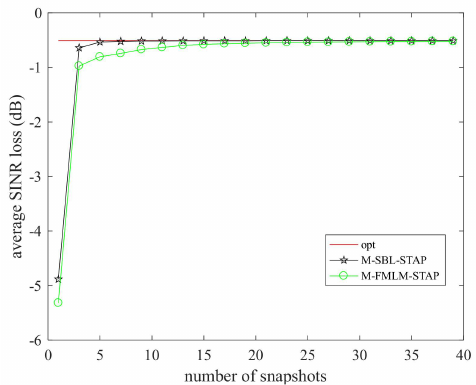
Figure 6. Average SINR loss to the number of training